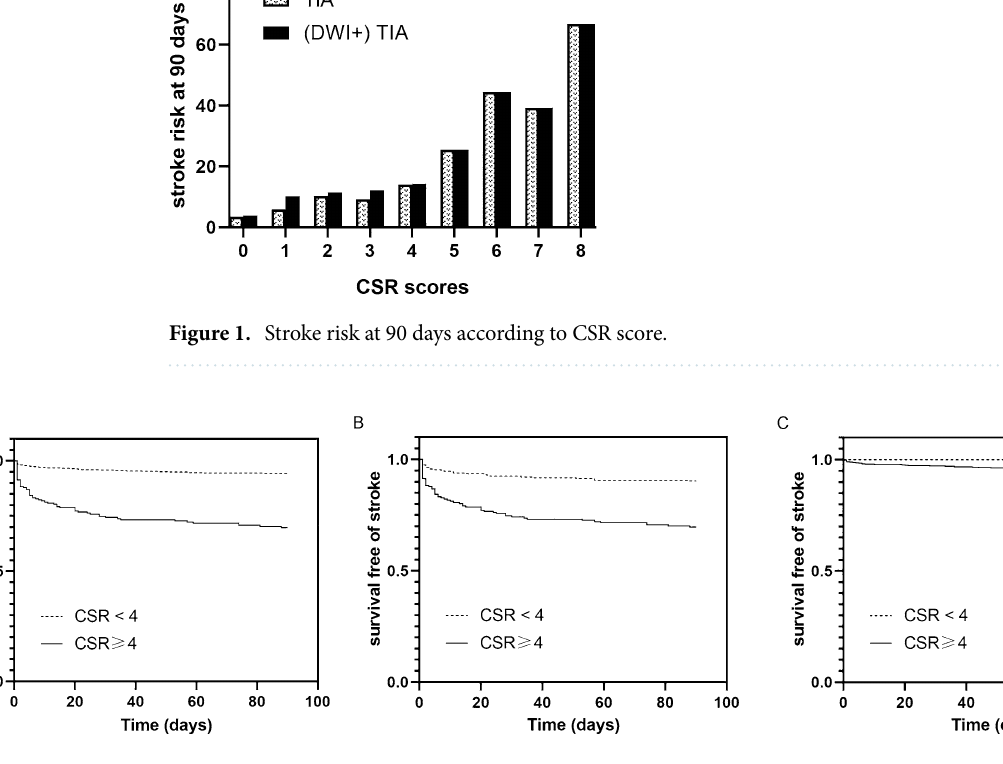
Figure 2. ( A ) Kaplan–Meier curves of TIA patients stratified according to the CSR model at 90 days (log-rank test = 121.70, P < 0.001); ( B ) Kaplan–Meier curves of DWI-positive subjects stratified according to the CSR model at 90 days (log-rank test = 33.75, P < 0.001); ( C ) Kaplan–Meier curves of DWI-negative subjects stratified according to the CSR model at 90 days (log-rank test = 6.89, P =